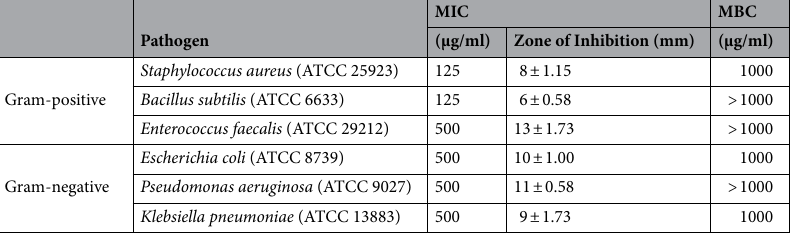
Table 3. Minimum inhibitory concentration (MIC) and minimum bactericidal concentration (MBC) of Kocuria sp. RAM1 carotenoids against some bacterial pathogens.